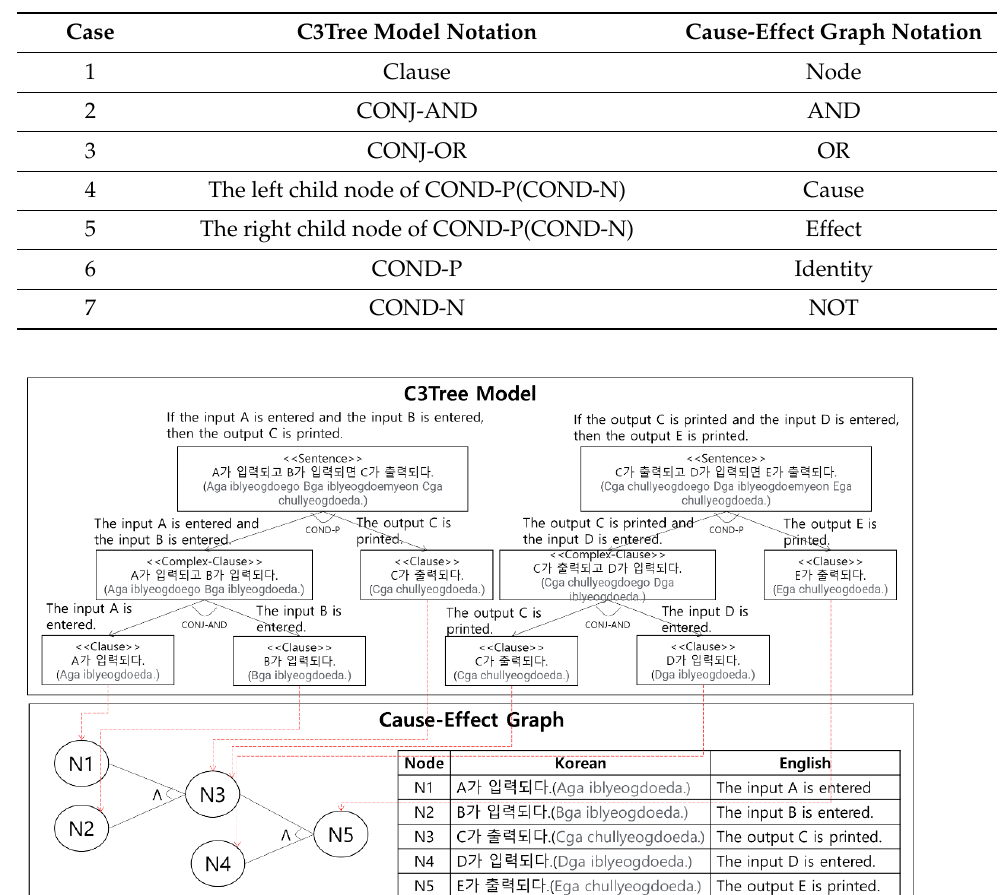
Figure 9. The transformation process of Cause-Effect Graph from C3Tree Model. Table 11. XMI Code of Cause-Effect Graph.